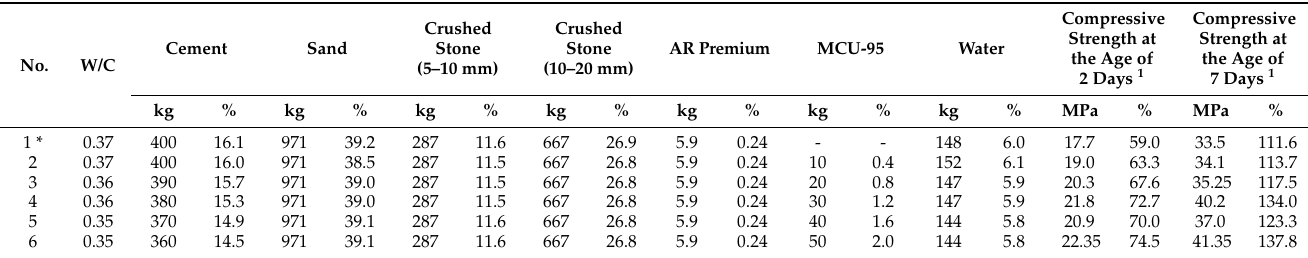
Table 13. Compositions of RHC with various contents of MCU-95 per 1 m 3 and data on the strength at the ages of 2 and 7 days of curing.